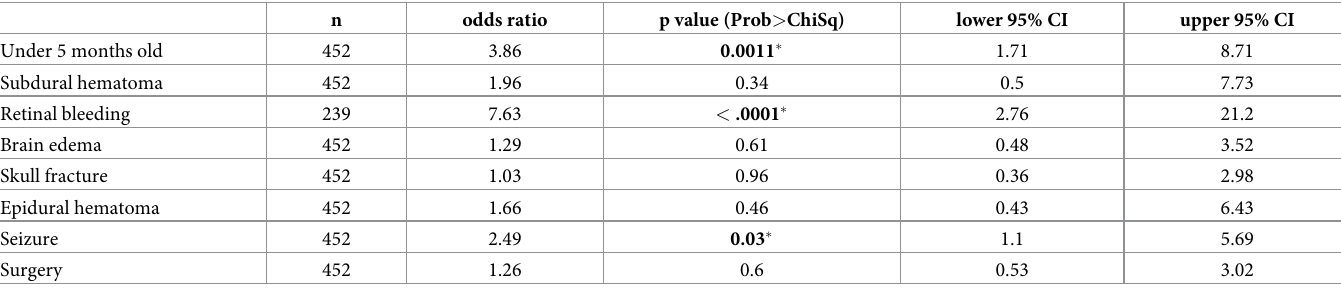
Table 6. Multivariate analysis of nonaccidental vs accidental. n odds ratio p value (Prob >